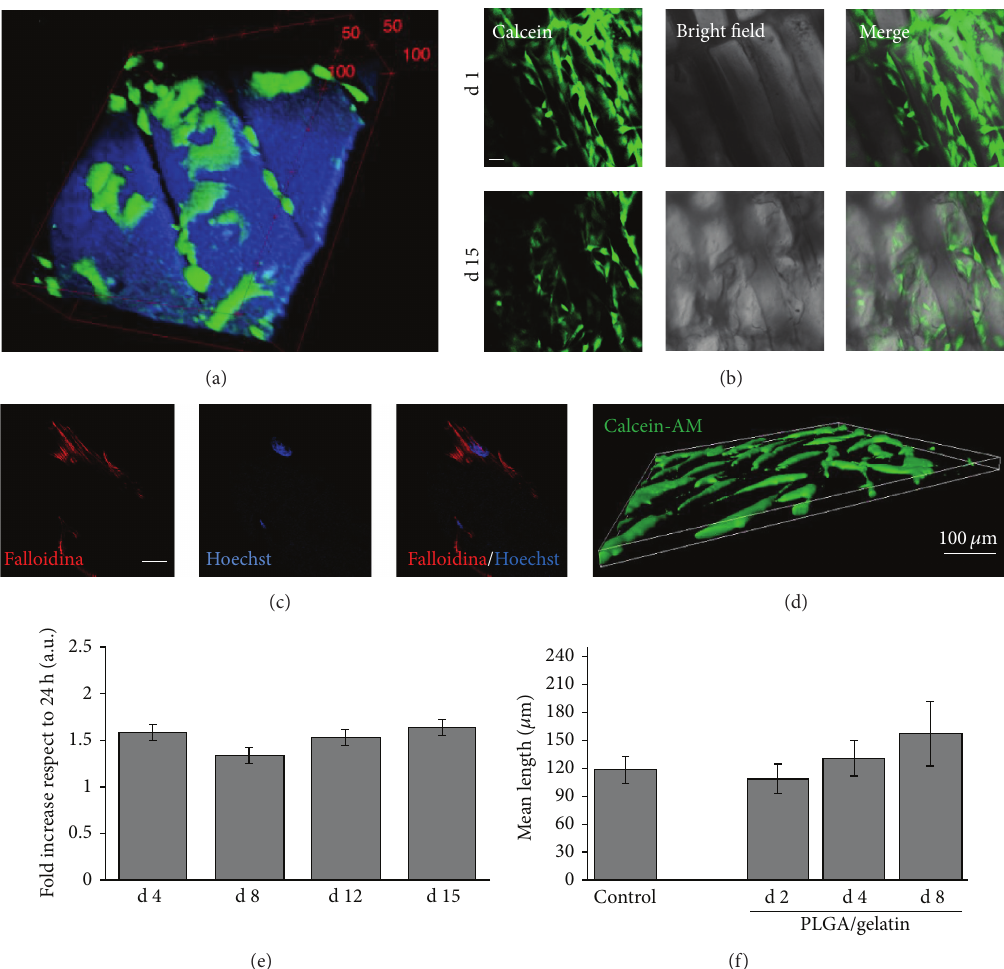
Figure 7: Stem cell colonization, growth, and elongation on monolayer and bilayer microstructured PLGA/gelatin scaffolds. (a) Stem cells stained with Calcein-AM and imaged using TPEF microscopy (green) visualized on a monolayer microstructured PLGA/gelatin scaffold imaged using CARS microscopy (blue) after 8 hours from seeding. Red arrows indicate a few hMSCs aligned in parallel inside the scaffold lanes. (b) Representative confocal microscopy images of living hMSCs cultured for either 1 or 15 days on bilayer scaffolds. Superposition of Calcein-AM (green) and bright field microscopy is shown. Magnification 20x, scale bar 50 𝜇 m. (c) Representative confocal microscopy image showing cytoskeletal organization of hMSCs cultured for 15 days on a bilayer scaffold. Actin filaments are stained with phalloidin in red, cytoplasm with Cell Mask Green, and nuclei with Hoechst in blue. Magnification 63x, scale bar 20 𝜇 m. (d) 3D reconstruction of a representative image showing hMSCs cultured for 24 h on a monolayer scaffold. Cells are stained with Calcein-AM. Magnification 20x, scale bar 100 𝜇 m. (e) Cell proliferation rates after 4, 8, 12, and 15 days of culture on bilayer scaffolds. Values were normalized on cell adhesion quantified at 24 hr. (f) Mean cell lengths of hMSCs cultured on monolayer and bilayer scaffolds. Elongation measurements were performed on living cells stained with Calcein-AM at 2, 4, and 8 days of culture. Lengths were not statistically different from the 2D